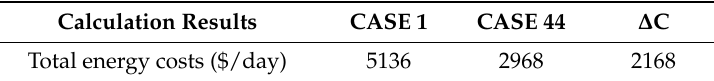
Table 4. Economic Efficiency